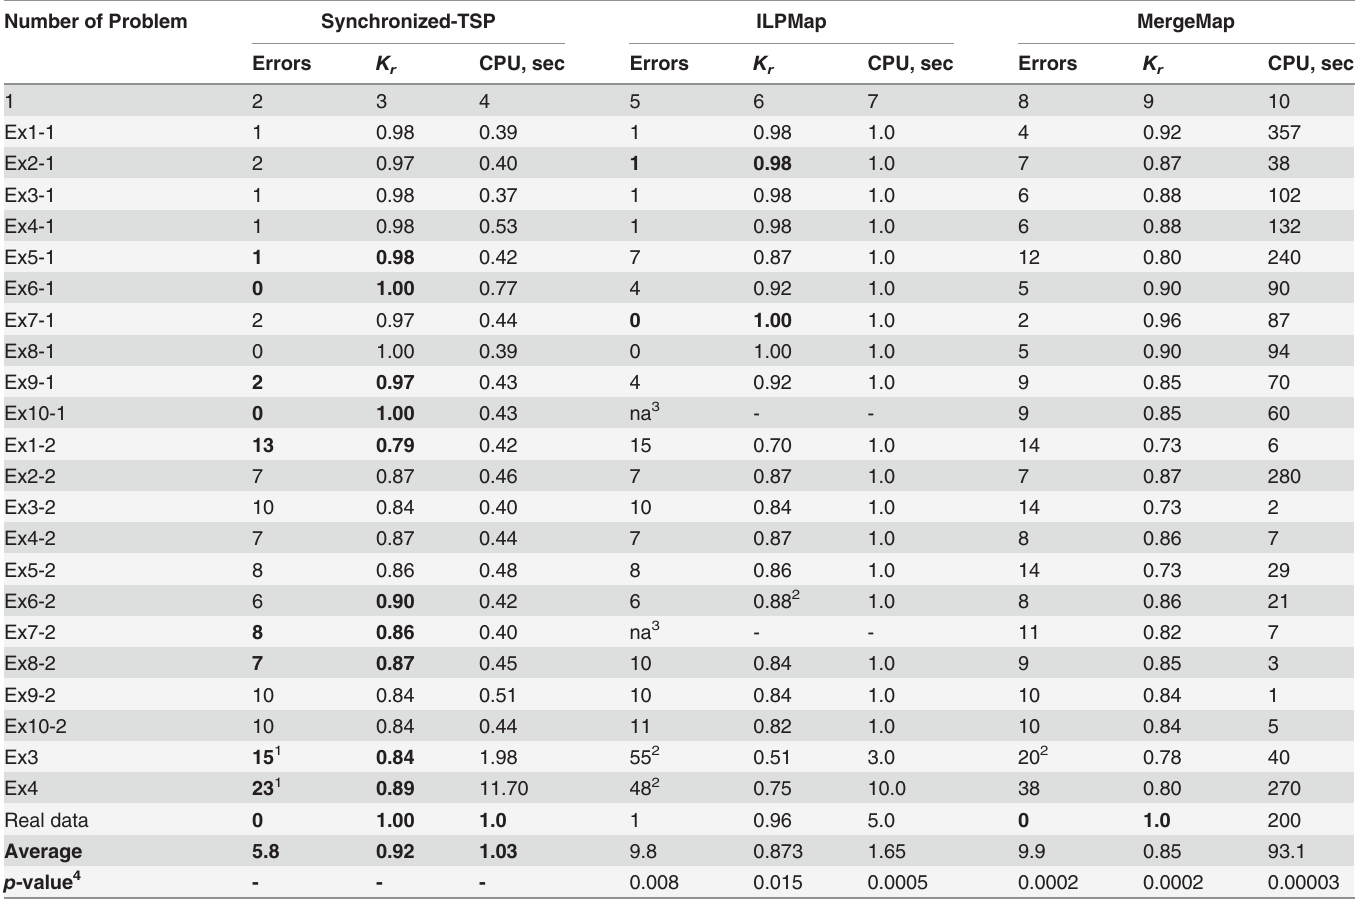
Table 5. Comparing the efficiency of three consensus mapping